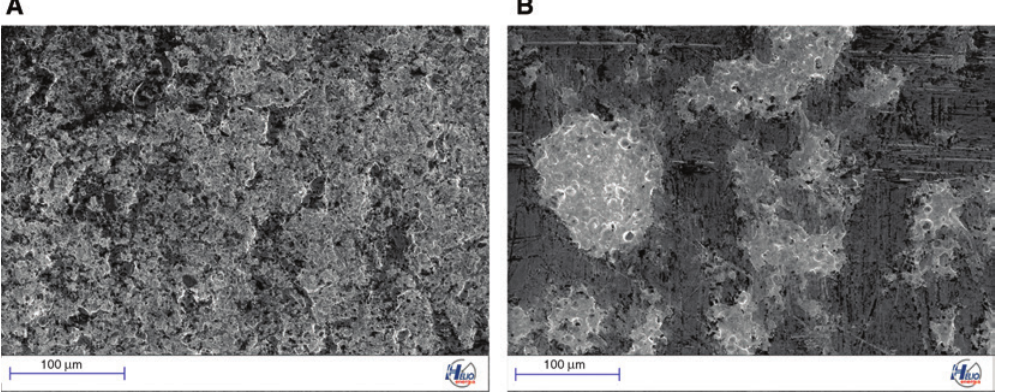
Figure 3: Layer procured as a result of thermal silver plating compared with the silver layer obtained from the galvanizing plant. (A) SEM picture of a sintered silver layer on the aluminium surface. (B) SEM picture of the silver layer procured in the electrochemical process on the aluminium